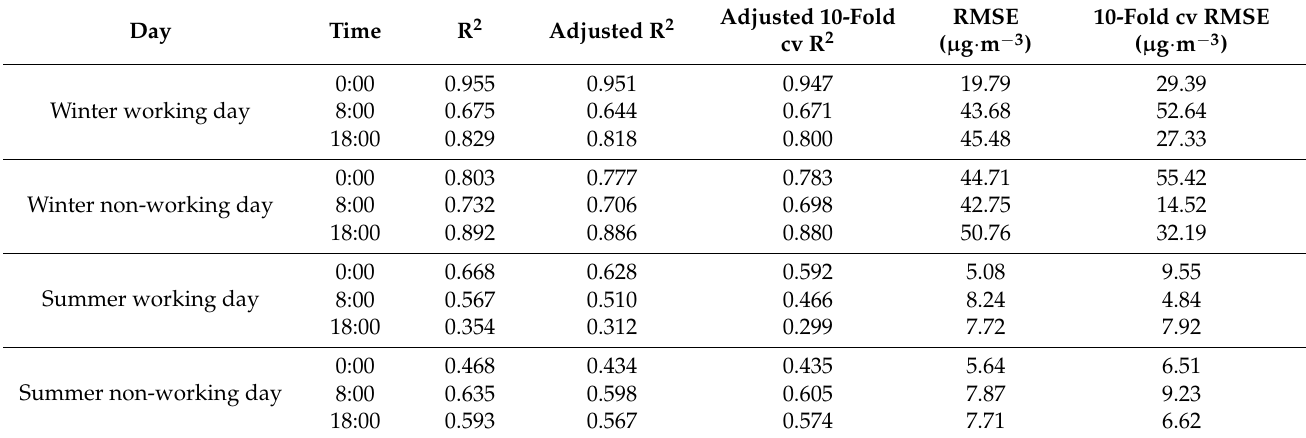
Table 3. Summary of the basic parameters of the different